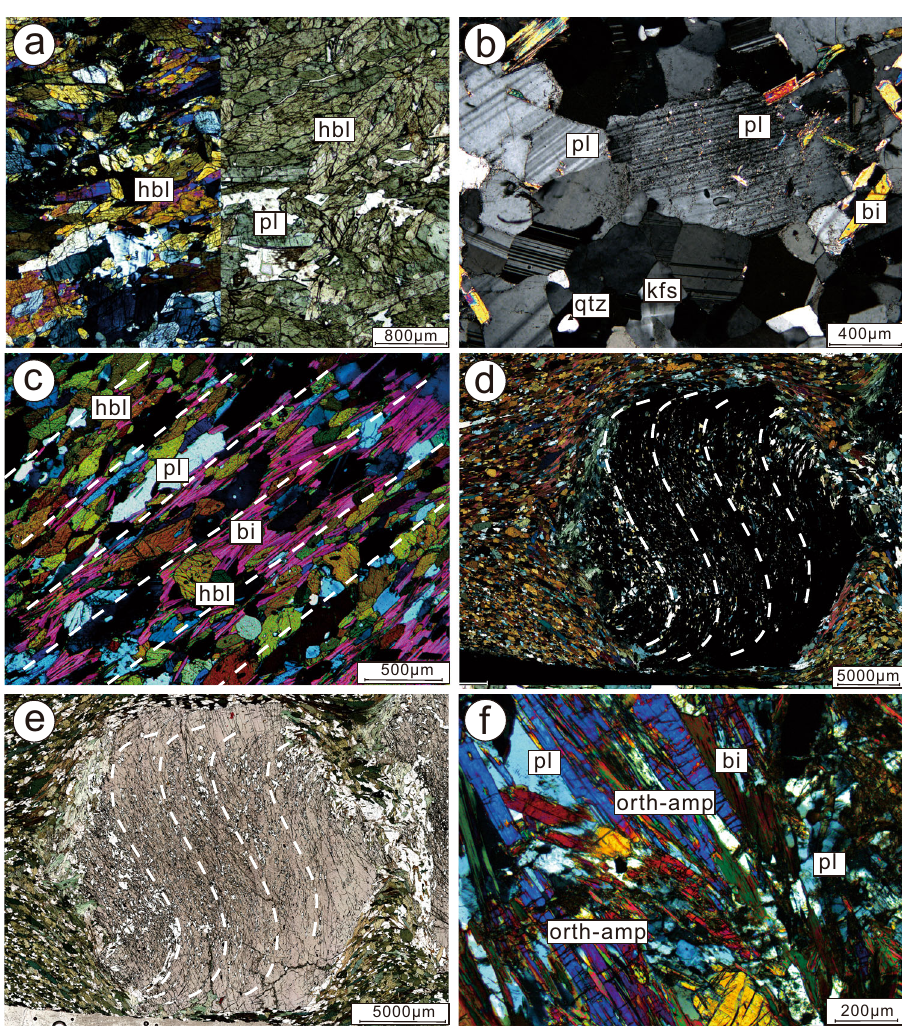
Fig. 5 Photomicrographs showing representative mineralogy and microstructures of typical lithologies. a The picritic-boninitic metabasite is predominately composed of large grains of hornblende with minor plagioclase; microphotograph shows a continuous view but left half is under cross polars and right half is under plane light; b microphotograph of the trondhjemite dike. The relict of original subhedral plagioclase phenocrysts corroborates the magmatic genesis for the precursor; c tholeiitic basalt is strongly foliated and chie fl y composed of garnet (shown in d , e ), biotite, amphibole, plagioclase, and quartz; d , e garnet forms rotated porphyroblast with sigmoidal and spiral-shaped inclusion trails making beautiful snowball garnet structures, which are traditionally interpreted as evidence for syntectonic crystallization; f schistes lustrés consisting of fl aky chlorite, biotite, and prismatic orthoamphibole